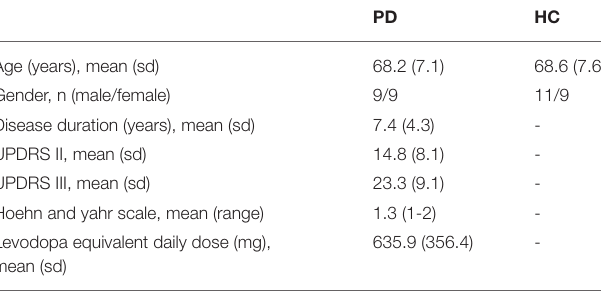
TABLE 1 | Demographic and clinical characteristics of the patients with Parkinson’s disease (PD) and healthy controls